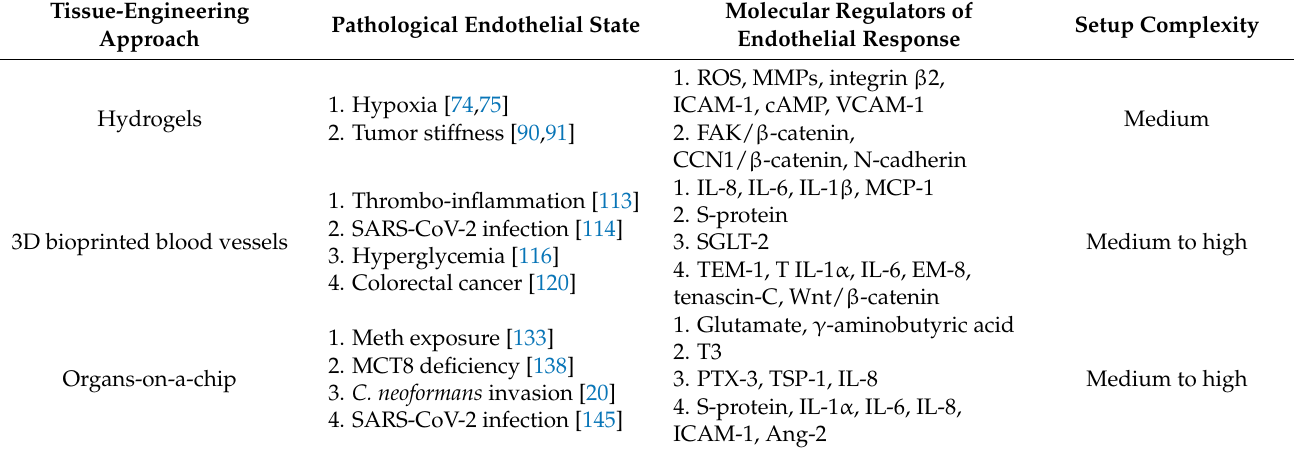
Table 1. Tissue-engineered models for the mechanistic study of the vascular